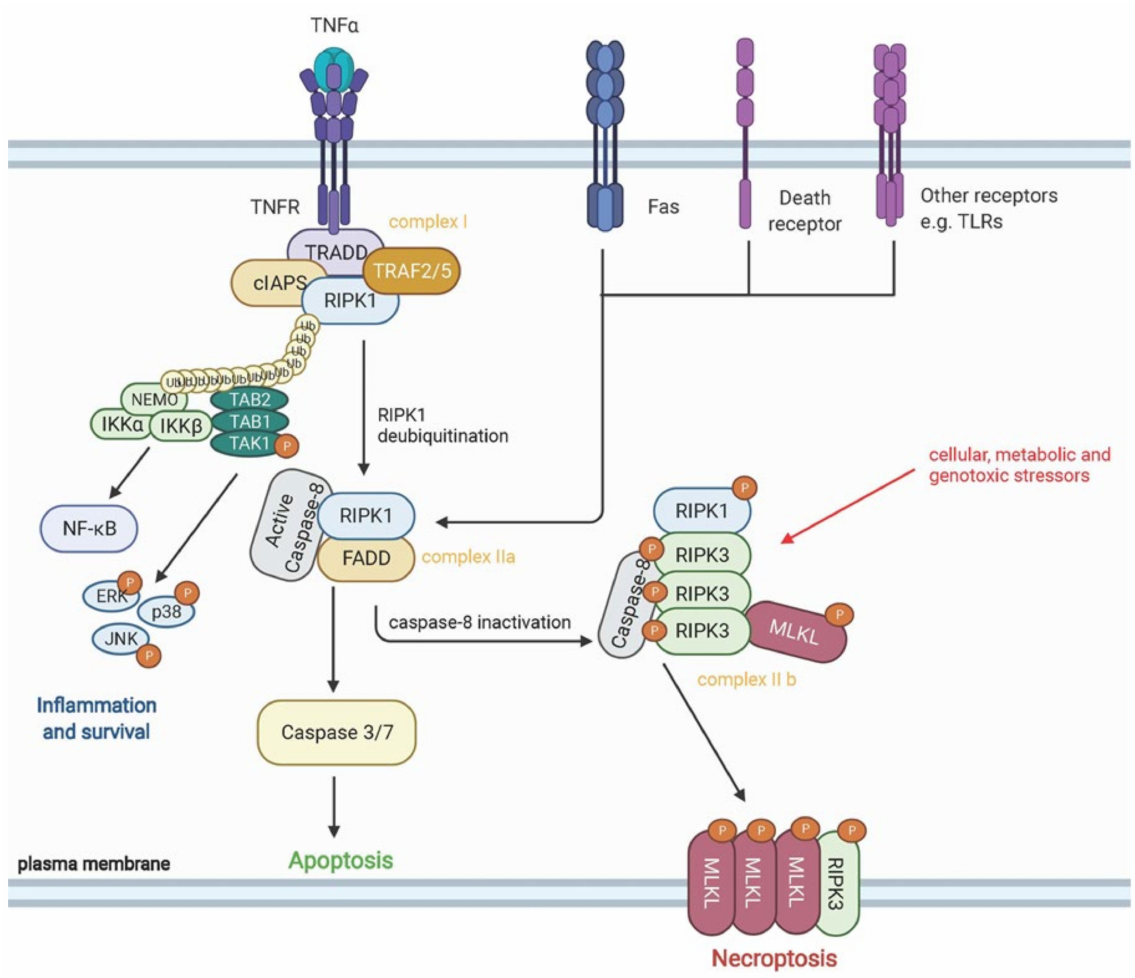
Figure 2. Schematic diagram of pathways involved in necroptosis. Necroptosis can be triggered downstream of death domain receptors (e.g., TNFR and Fas), toll-like receptors (e.g., TLR-4 and TLR-3) or in response to cellular, metabolic and genotoxic stressors. Upon activation of receptors, recruitment of adaptor proteins including TRADD, TRAF2/5, RIPK1, cIAPs and other molecules occurs to form complex I. Polyubiquitination of RIPK1 by cIAPs prevents RIPK1 function and activates NF-kB, leading to expression of proinflammatory cytokines and cell survival. Conversely, RIPK1 deubiquitination by CYLD leads to the formation of complex IIa, with Caspase-8 activation preventing activation of RIPK1 and necroptosis. Inactivation of Caspase-8 in complex IIa causes phosphorylation and activation of RIPK1, RIPK3 and MLKL during the assembly of complex 11b—also known as the necrosome. Phospho-MLKL oligomers then translocate to the plasma membrane and form large pores, leading to necroptotic cell death by facilitating ion influx, cell swelling and membrane lysis, followed by the passive release of intracellular molecules into the tissue microenvironment. Created using